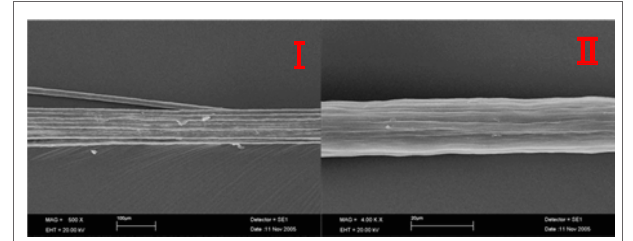
FiGURe 1 | SeM of SMF-3 . View of multifilament (500 × ) (Ji et al., 2006 © IOP Publishing. Reproduced with permission. All rights